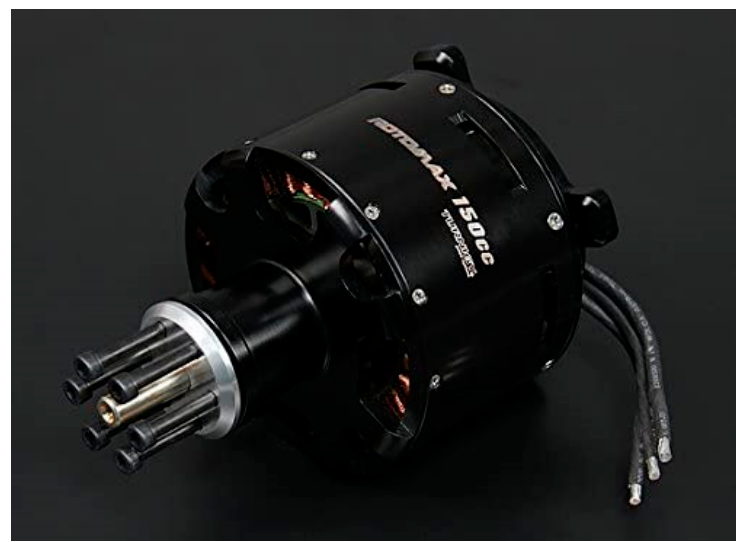
Figure 11. ROTOMAX 150 cc BLD MOTOR™. Table 5. BLDC specifications. Variables with an asterisk have been measured on a test bench or electronic instrumentation.